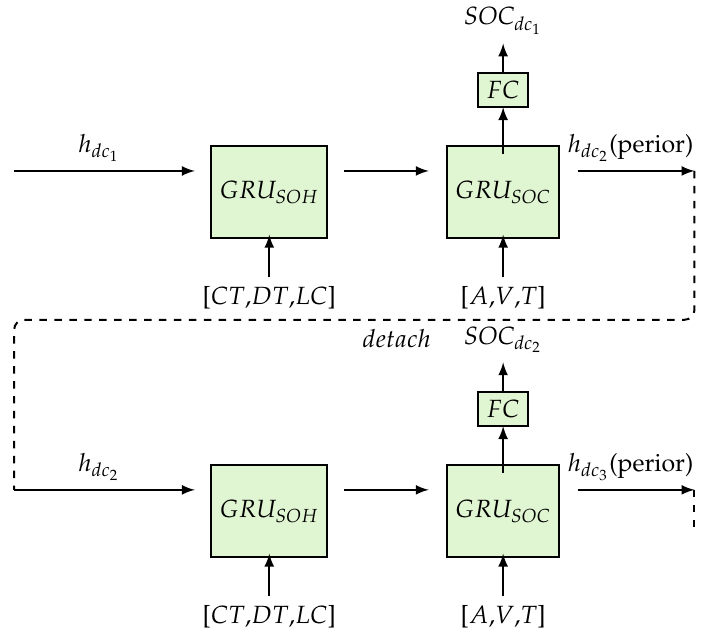
Figure 5. Structure of proposed SOC estimation